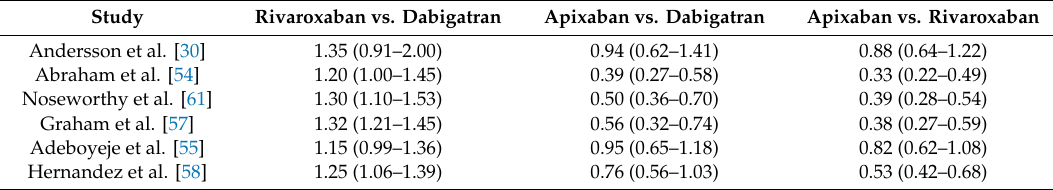
Table 6. Adjusted hazard ratios with 95% confidence intervals from direct pairwise comparison of di ff erent NOACs for major gastrointestinal bleeding. Study Rivaroxaban vs. Dabigatran Apixaban vs. Dabigatran Apixaban vs. Rivaroxaban Andersson et al.